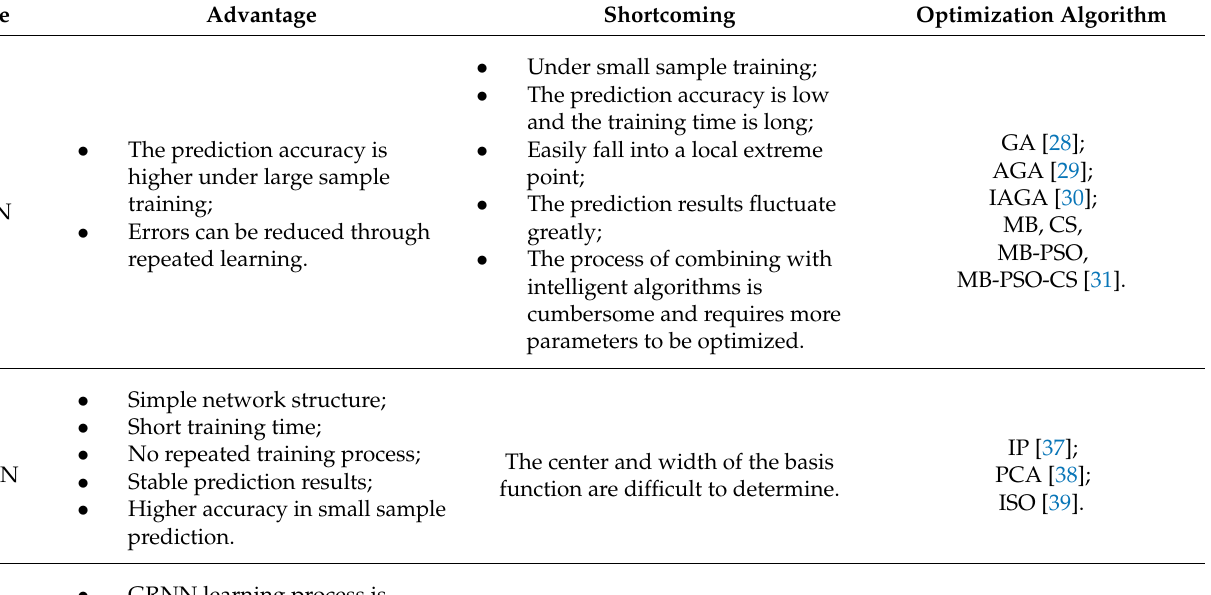
Table 4. Comparison summary of four artificial neural